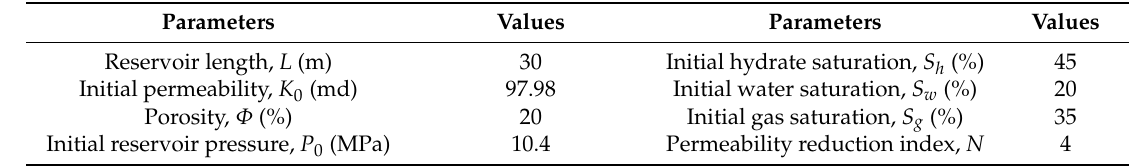
Table 2. Reservoir basic parameters values in the hydrate depressurization